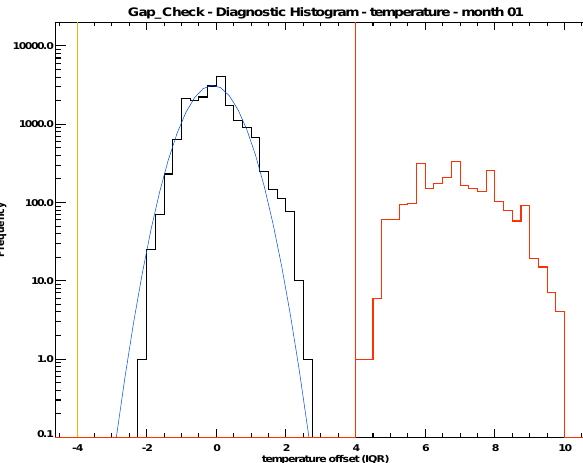
Fig. 8. Distribution of the observations from all Januaries in the sta- tion record for composite station 476960-43323, Yokosuka, Japan (35.58 ◦ N, 139.667 ◦ E, 530m). The population highlighted in red is removed by the distributional gap check (test 6), as shown in Fig. 7. Note logarithmic